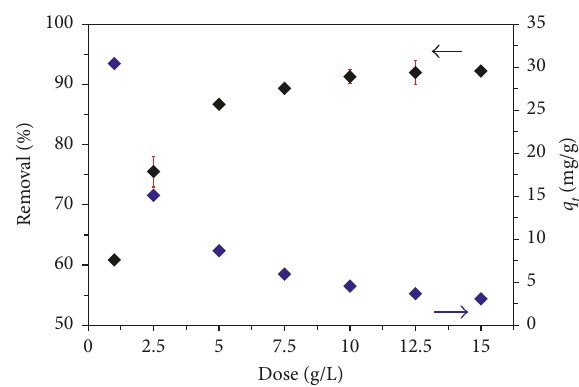
Figure 7: Influence of the adsorbent dose on the NH 4+ removal efficiency and uptake capacity of Al-waste-NaP1. Conditions: pH 7.5; contact time (cid:29)